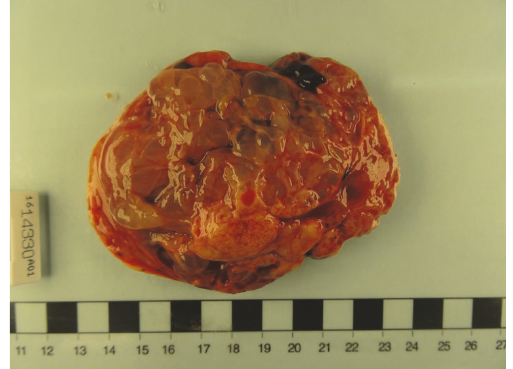
Figure 4: Macroscopic